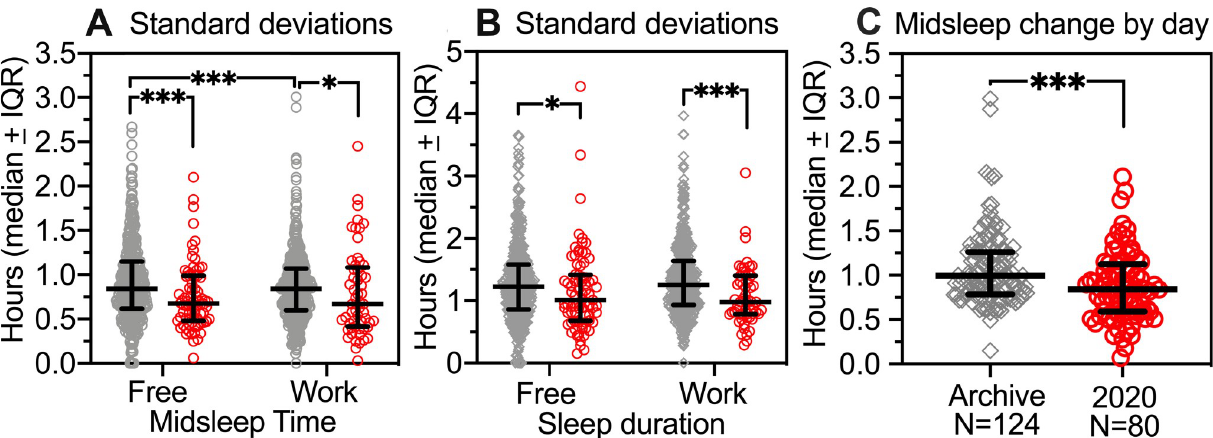
Fig 7. Within-subject variability (average standard deviations) of sleep timing and duration. [A]. Individual standard deviations of midsleep time in the 2020 group (red shading; N = 57 work days, N = 78 free days) and archive group (grey diamonds; N = 439 work, N = 431 free) for subjects with more than one work or free day. [B]. Individual standard deviations of sleep duration. [C]. Average daily change (absolute values) of midsleep time for individual subjects in the 2020 group and in a subset of the archive group. Between-group contrasts by Mann-Whitney U test. Within-group contrasts by Wilcoxon matched pairs signed rank test. � p < .05, ��� p <